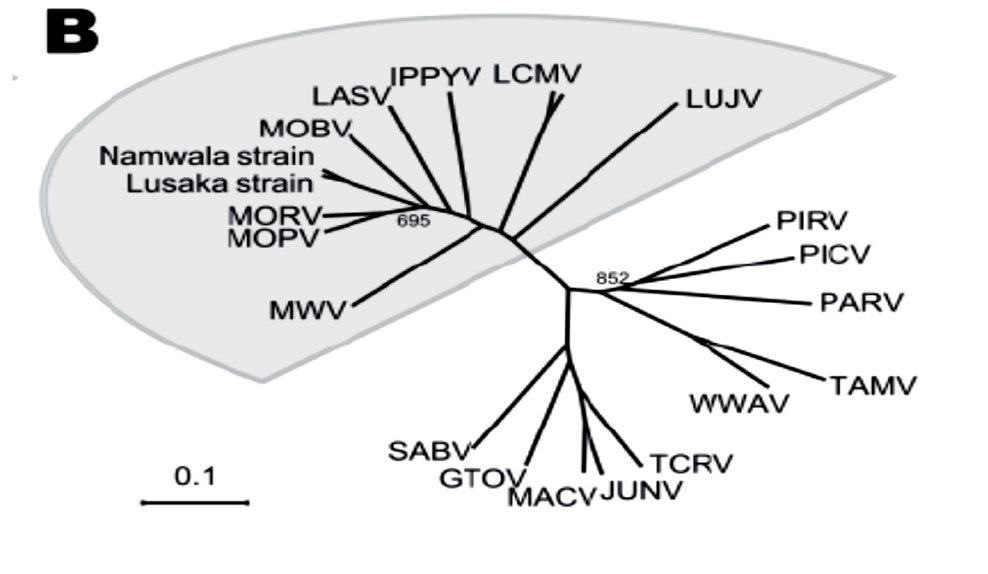
Figure 1 (b). Phylogenetic relationships among the Old World arenaviruses (grey sector) based on analysis of the NP gene. From A. Ishii et al with permission [10]. See text for more